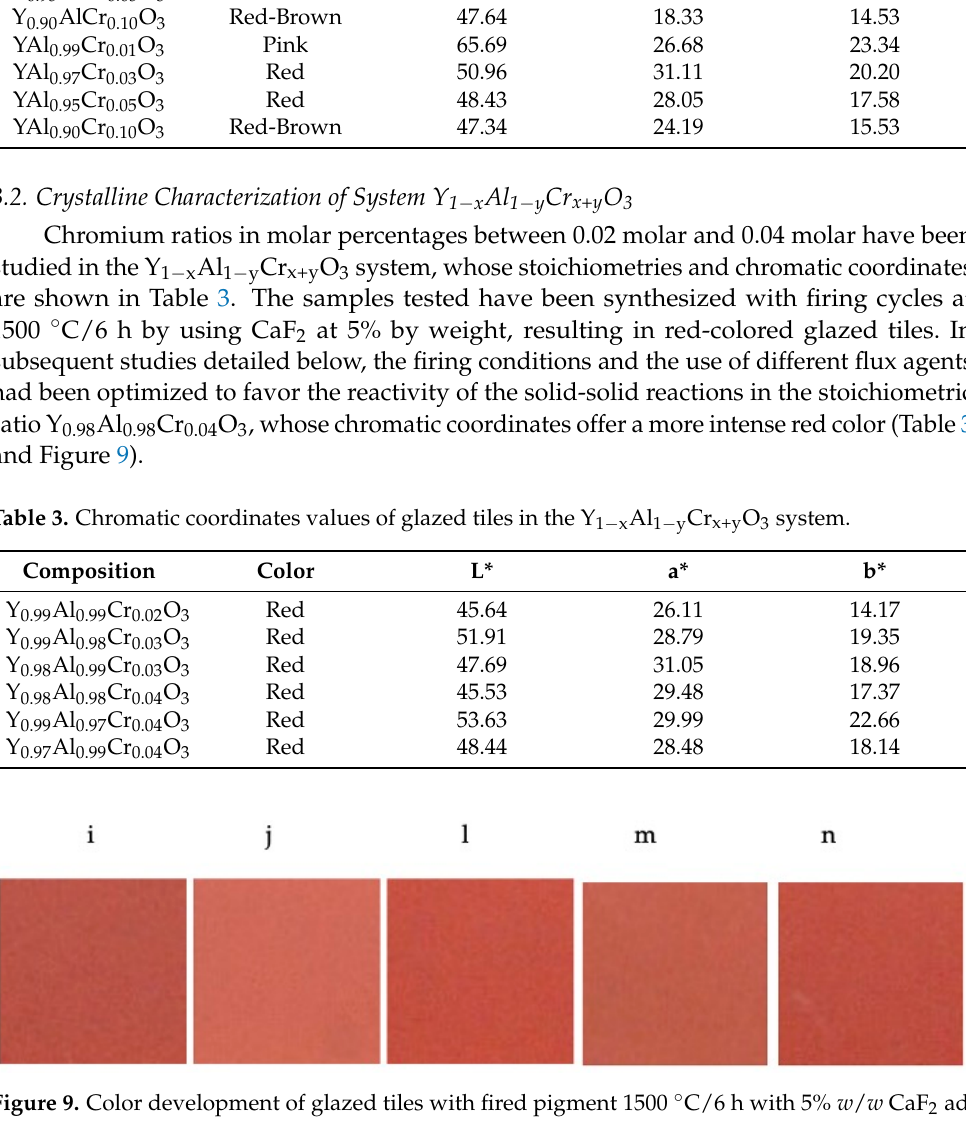
Table 4. Chromatic coordinates values of glazed tiles in the Y 0.98 Al 0.98 Cr 0.04 O 3 system at different fir- ing temperatures.